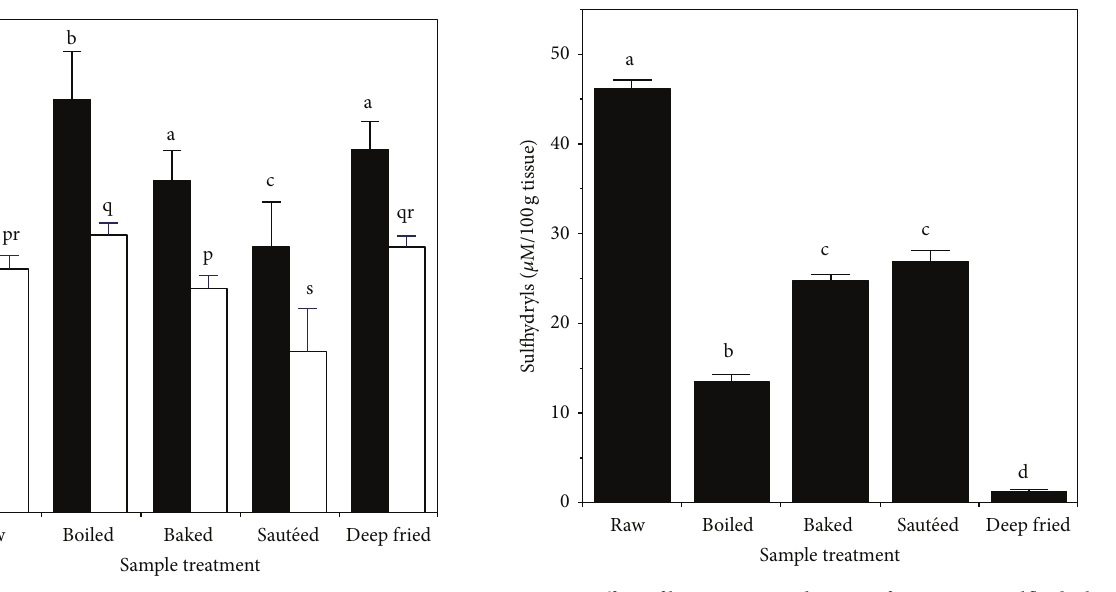
Figure 3: Effect of heating on production of soluble and dialyzable protein during digestion of chicken muscle: ◼ soluble protein; ◻ dialyzable protein. Values are the mean ± standard deviation ( 𝑛 = 10 ). Means without a common letter differ at 𝑃 < 0.05 .